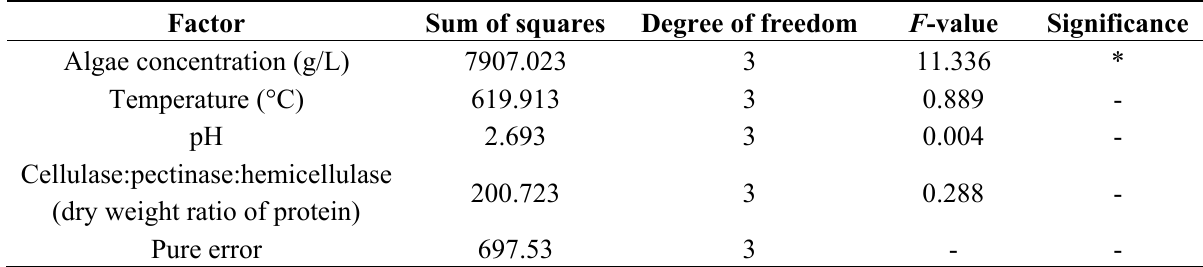
Table 3. Analysis of variance (ANOVA) for the orthogonal